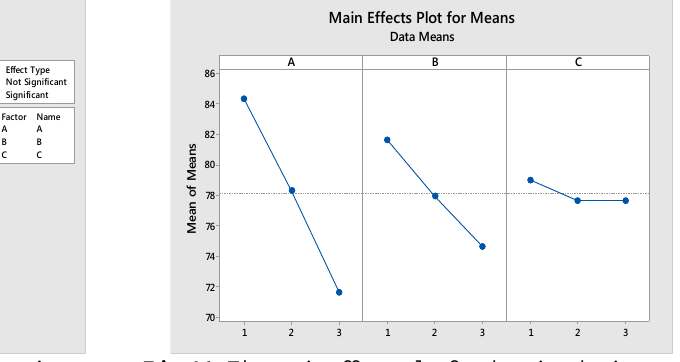
Fig. 10. The normal plot of the effects between input parameters for the proposed hybrid method